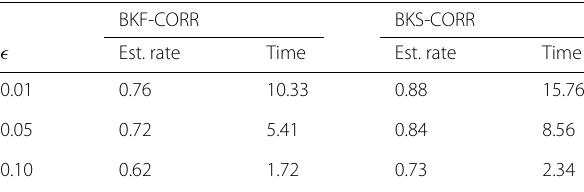
Table 3 Effect of the pruning parameter on performance and